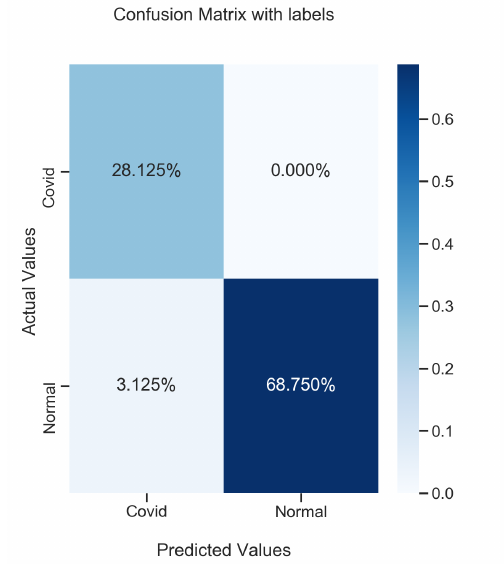
Figure 18. Confusion Matrix case 4 in Table 9.